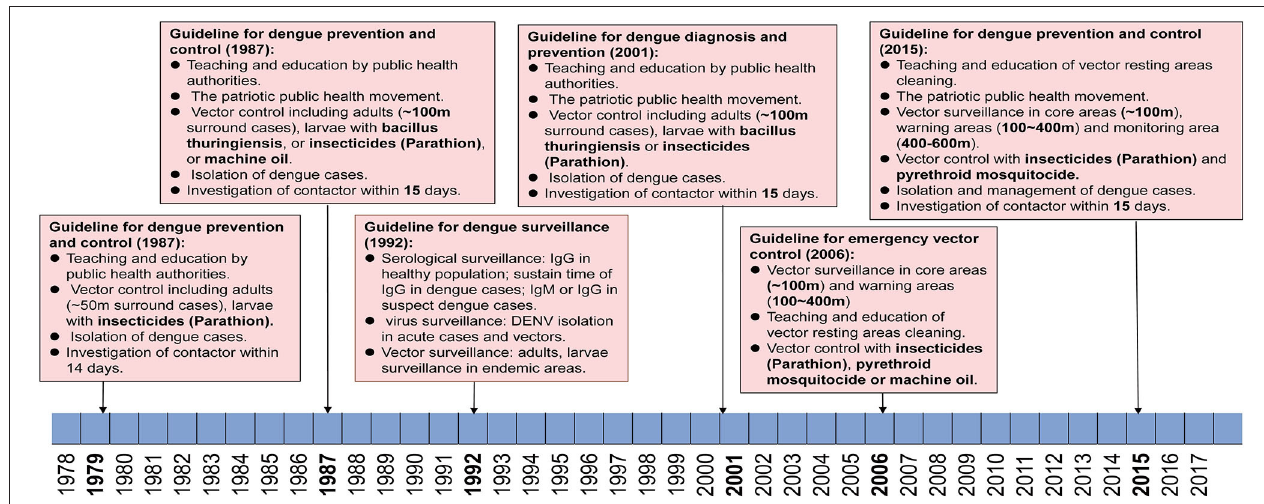
FIGURE 5 | Reforming of dengue prevention and control strategies from 1979–2017. Criteria and policies’ formulation and development in Guangdong are summarized according to the date of application and dengue